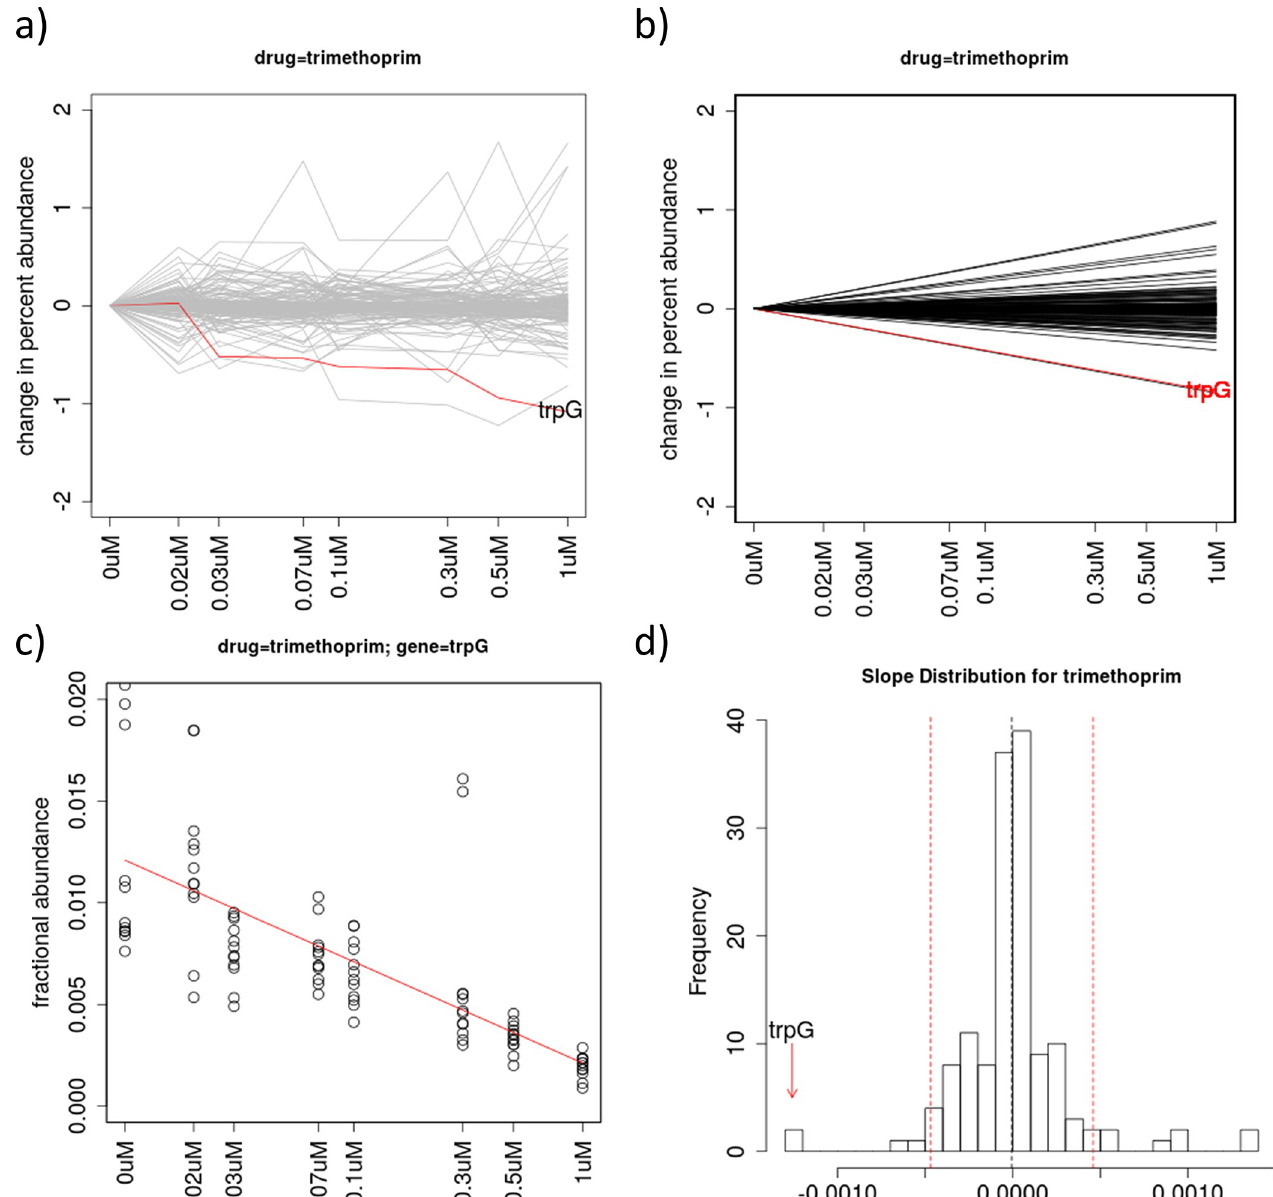
Fig 1. Analysis of data for treatment of an M . tuberculosis hypomorph library with trimethoprim. (a) Plot of relative abundances of knock-down mutants for all 162 genes in the library, with the known interacting gene trpG highlighted in red, showing depletion as concentration increases. The Y-axis represents the change in percent abundance of each gene, which is calculated by subtracting the mean relative abundance for each gene at 0 μ M, so they all fan out from 0 in the superposition. (b) Plot of regression lines for all the genes based on slopes as random-effect coefficients in the linear mixed-model, fit to the abundance data in (a). (c) Plot of relative abundance data points and regression line fit specifically for trpG , as an illustration of the variability of the data among concentrations and replicates. (d) Histogram of the slope coefficients for all genes in the library, with trpG highlighted as an outlier (most negative slope). The dashed red lines indicate the outlier cutoffs defined by Zrobust = ±